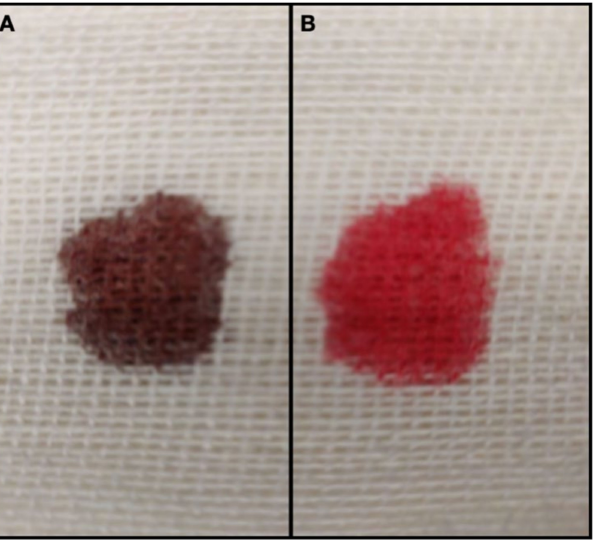
Figure 2. Methemoglobine spot test. ( A ) At admission the blood remains noticeably brown in color (MetHb 81.4%). ( B ) Three hours after the administration of methylene blue the blood was bright red (Met 4.2%).